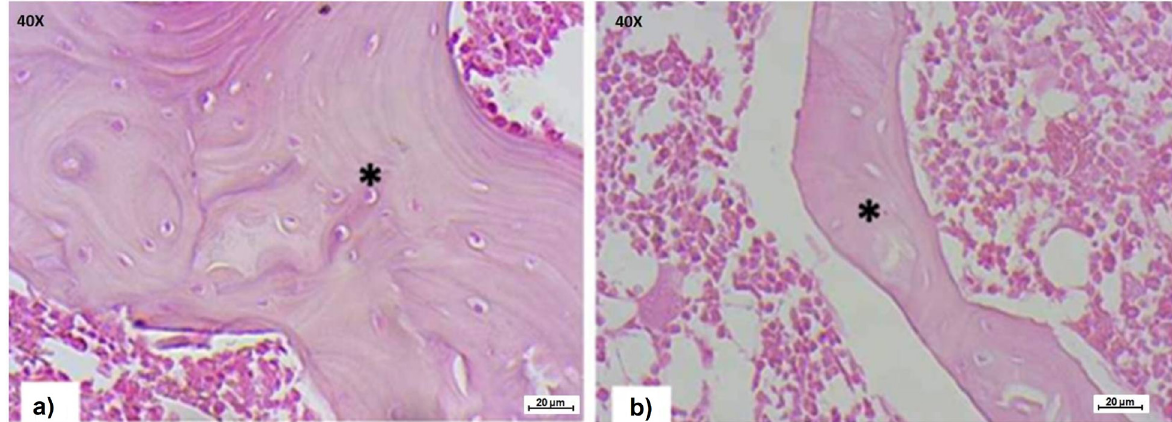
Figure 2. Bone trabeculae* from the femoral neck of rats a) not submitted to alcohol intake and b) submitted to ethanol intake. Hematoxylin and eosin (HE), original magnification 400x.